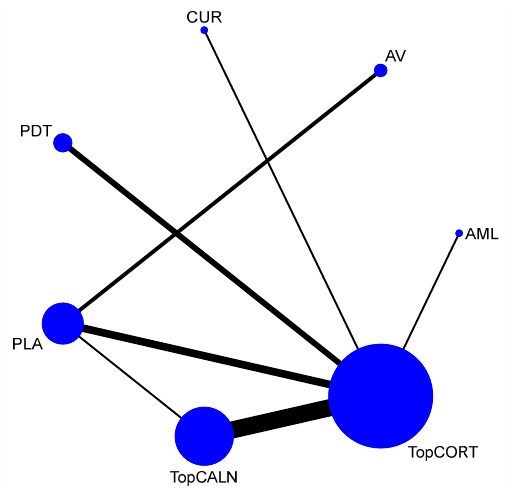
Figure 8. Network Plot: Clinical Resolution of Oral Lichen Planus. Abbreviations: AML, amlexanox paste; AV, aloe vera; CUR, curcumin gel; PDT, photodynamic therapy; PLA, placebo; TopCALN, topical calcineurin; TopCORT, topical corticosteroid.